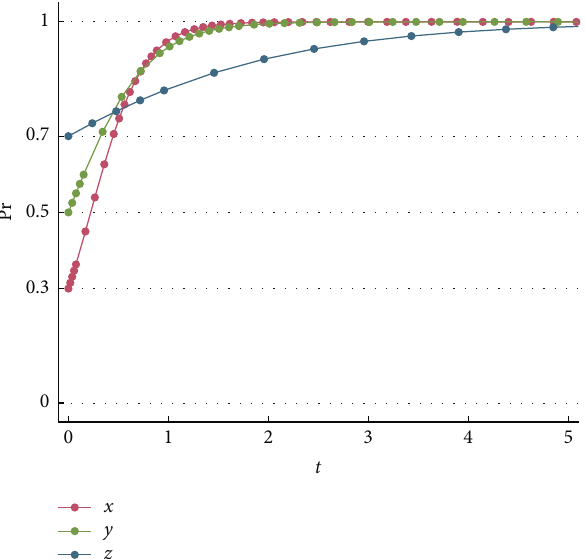
Figure 5: The final evolution result of E setting.